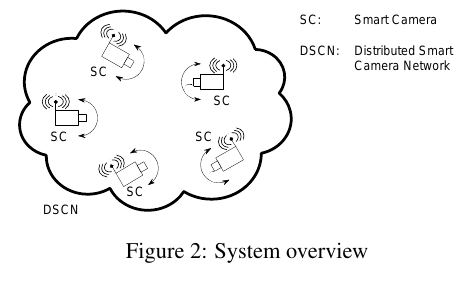
Figure 2: System